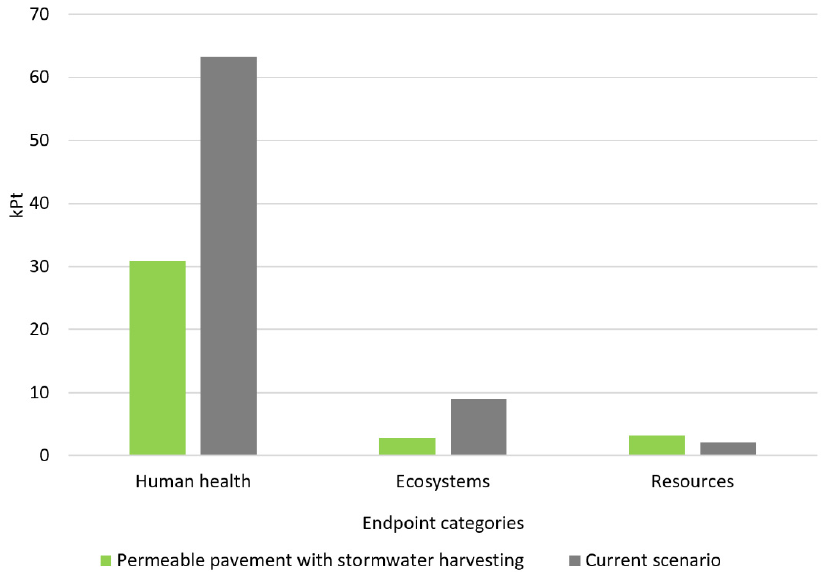
Figure 5. Comparison of scenarios through the endpoint categories (weighted data).